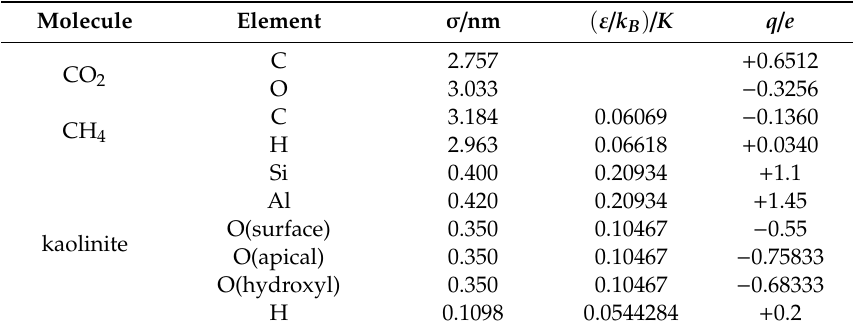
Table 1. Lennard–Jones parameters and atomic